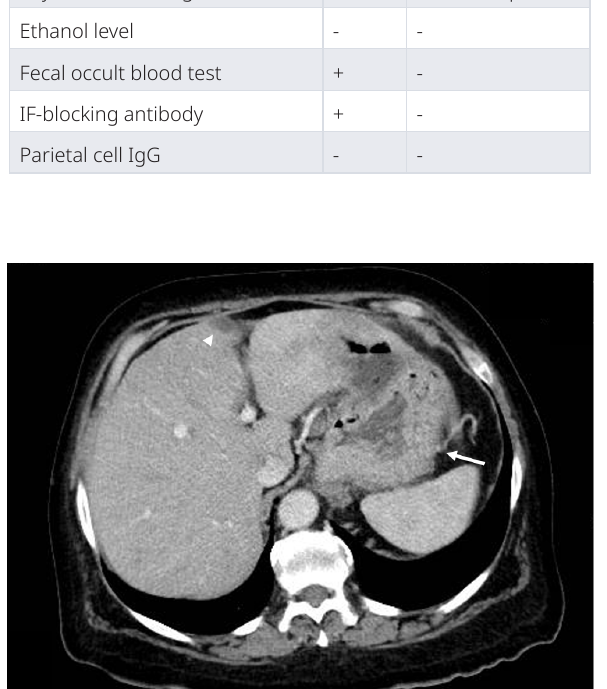
Figure 1. Abdominopelvic CT scan with contrast is primarily nonrevealing for a malignant process. Nonspecific gastric fold thickening in the fundus is observed ( arrow ). An incidental finding in the liver was noted by a small focal hypoattenuation in the middle segment of the left lobe of the liver adjacent to the fissure for ligamentum teres ( arrowhead ). This nodule was confirmed as PET-negative on later PET/CT